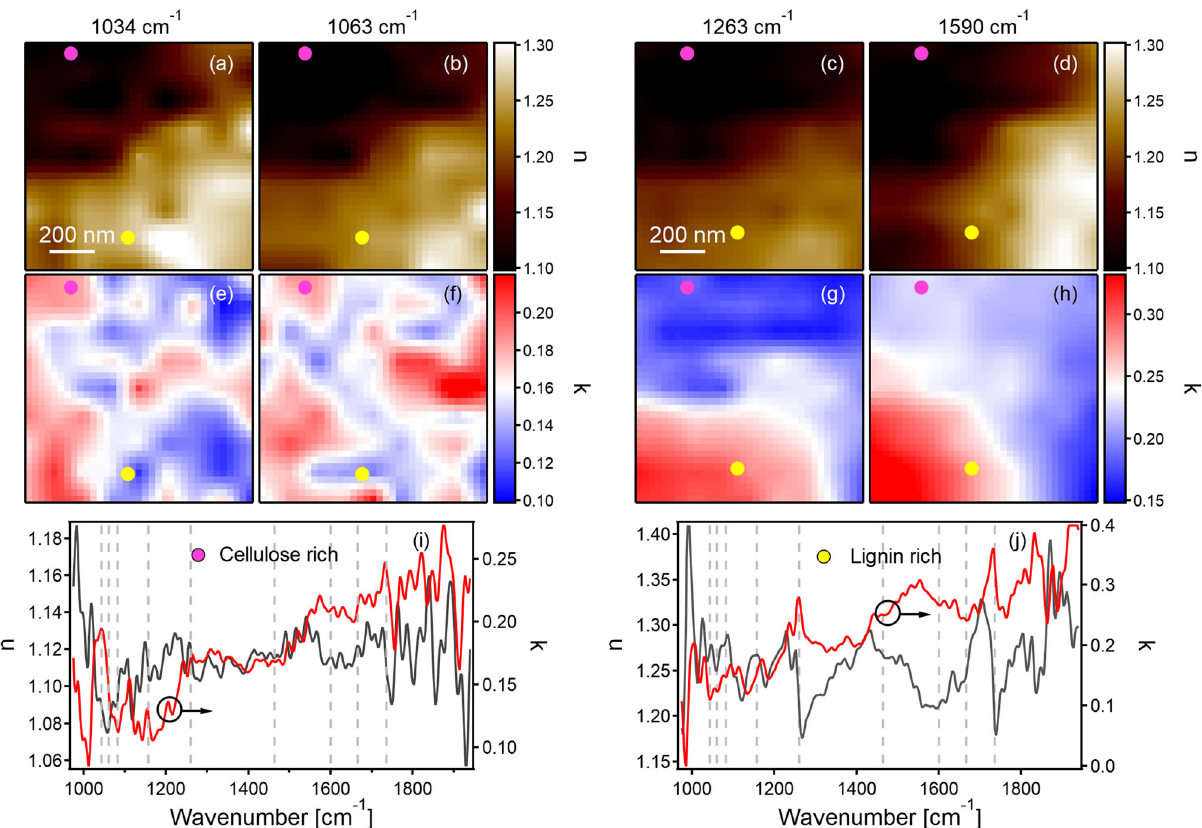
Fig. 5 In situ high-resolution determination of nanoscale optical properties of PCW in their native form. Measurement of the complex index of refraction n + ik for cellulose ( a – b , e – f , i ) and lignin ( c – d , g – h , j ), over a 1 × 1 µ m 2 region, is calculated from the re fl ectivity and absorption hyperspectral measurements of EA sample by selecting the speci fi c slices (Fig. 3). Images a – b and e – f display the indices mappings at 1034 and 1063 cm − 1 absorption peaks for cellulose. c – d and g – h show the lignin optical response by targeting speci fi c peaks at 1263 and 1590 cm − 1 . i and j display the spectral dispersion of (n, k) (n, k) n and k mappings ( a – h ) as C (Pink) for a cellulose-rich cellulos e and lignin , respectively. These spectra are evaluated at the points marked in the location and L (Yellow) for a lignin-rich